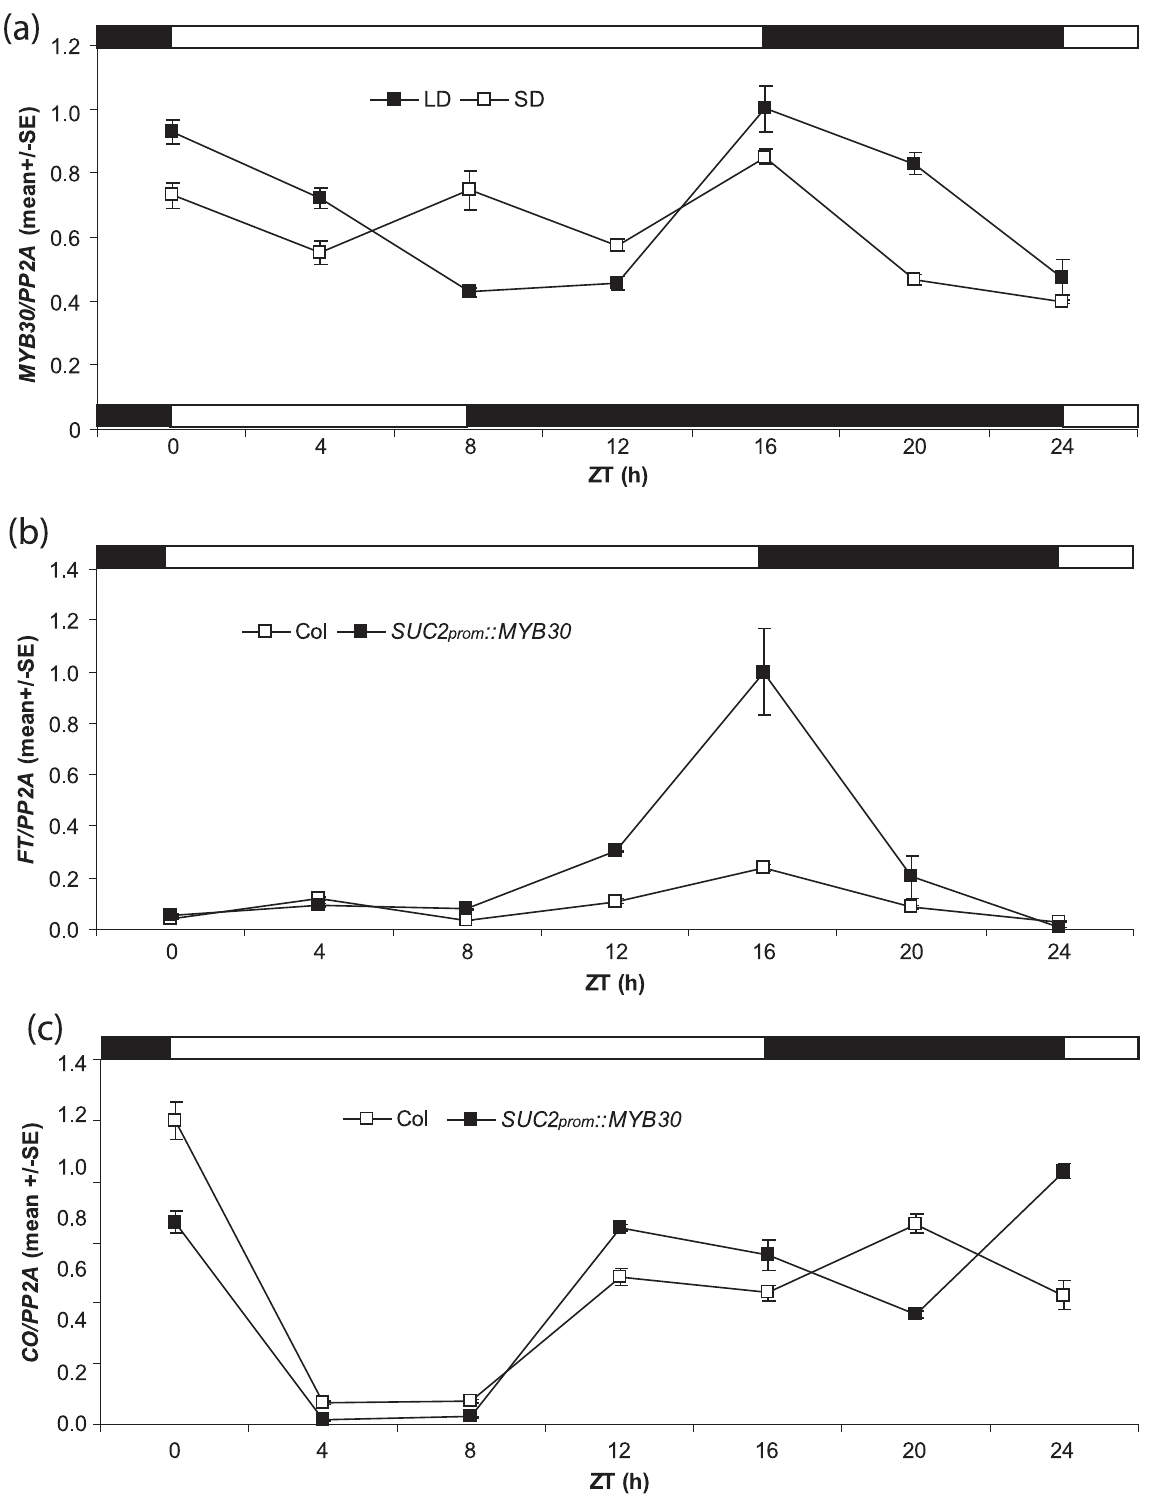
Figure 2. Diurnal expression of MYB30 , FT and CO . ( a ) Diurnal expression pattern of MYB30 was measured in Col grown in LDs and SDs by RT- qPCR. Total RNA was prepared from 10-day old seedlings sampled every 4 hours (ZT0-ZT24). ( b ) FT expression was measured comparing WT to SUC2 prom ::MYB30 expressing Col plants. 10-day-plants in LDs were collected every 4 hours from ZT0-ZT24. ( c ) CO expression was measured comparing WT to SUC2 prom ::MYB30 expressing Col plants. 10-day-plants in LDs were collected every 4 hours from ZT0-ZT24. Error bars represent the standard error of three technical replicates relative to the expression of PHOSPHATASE 2A ( PP2A ). The experiment was repeated three times with similar results.